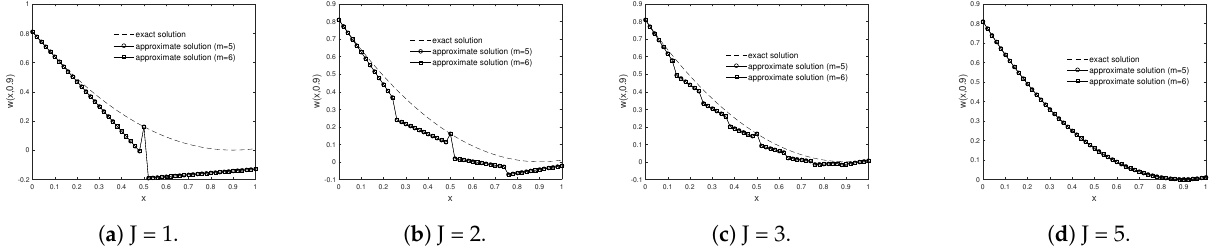
Figure 10. Effect of the refinement level J and δ t on the absolute error for Example